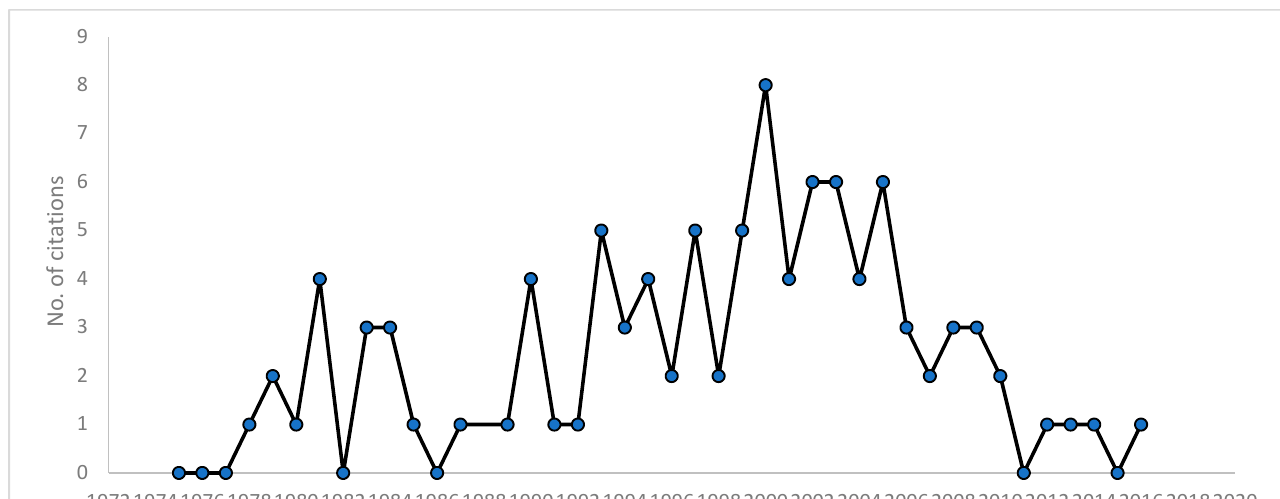
Figure 3. Publication trends for the 100 included publications.